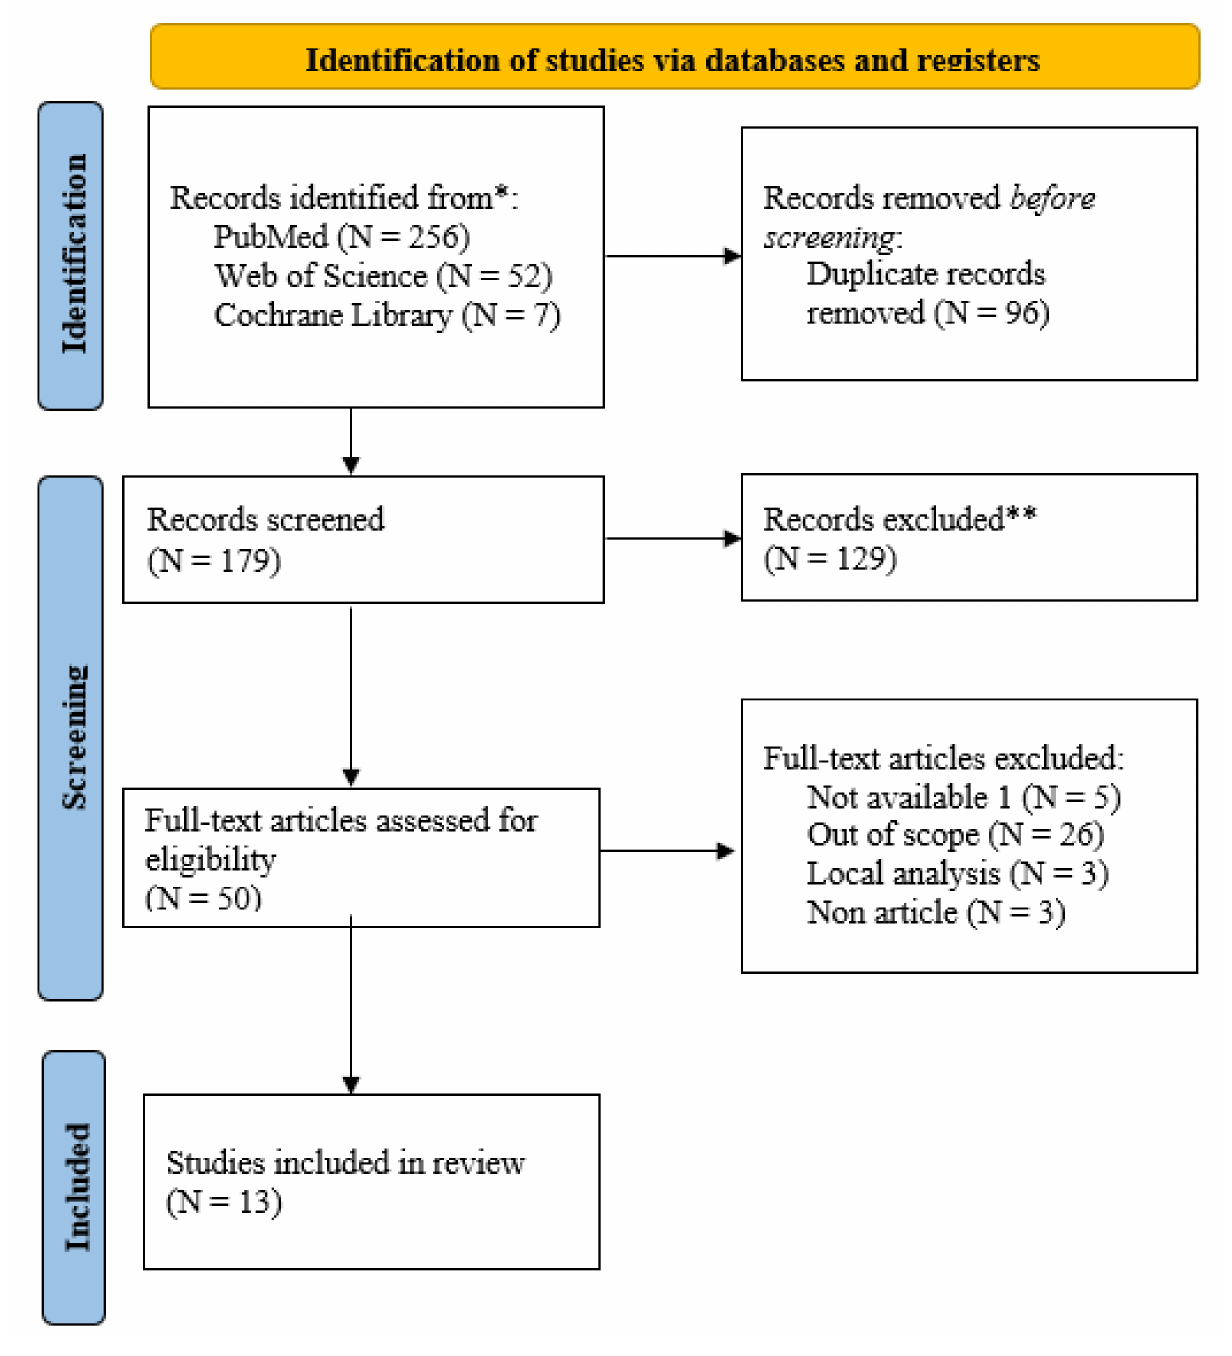
Figure 1. Flow diagram of the paper selection process. * publications from the databases considered. ** after considering the eligibility criteria described in the